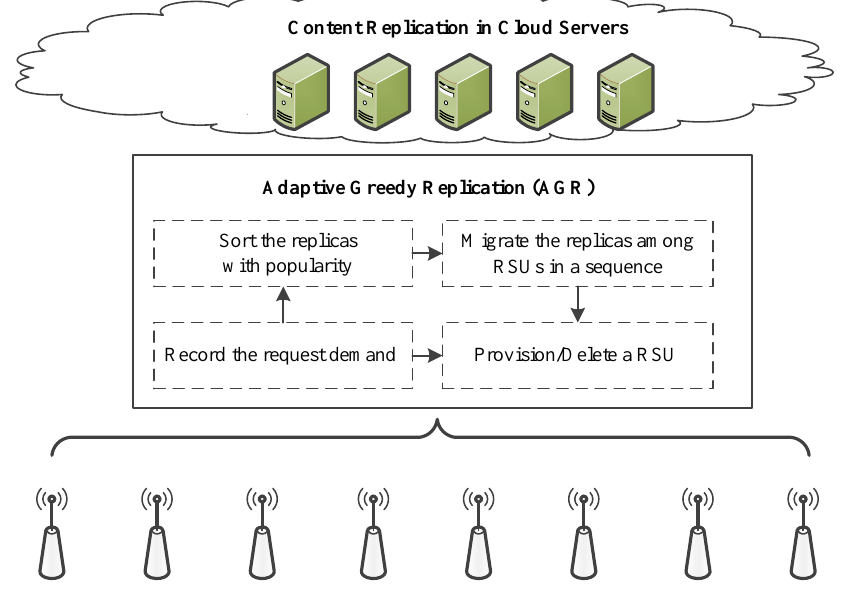
Figure 6. Adaptive greedy